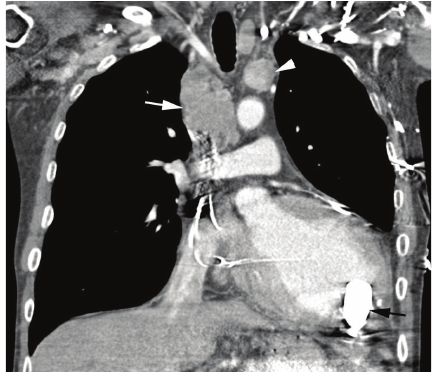
Figure 2: Coronal IV contrast-enhanced CT image shows right (white arrow) and left (white arrowhead) paratracheal lym- phadenopathy. LVAD inflow cannula within the left ventricle (black